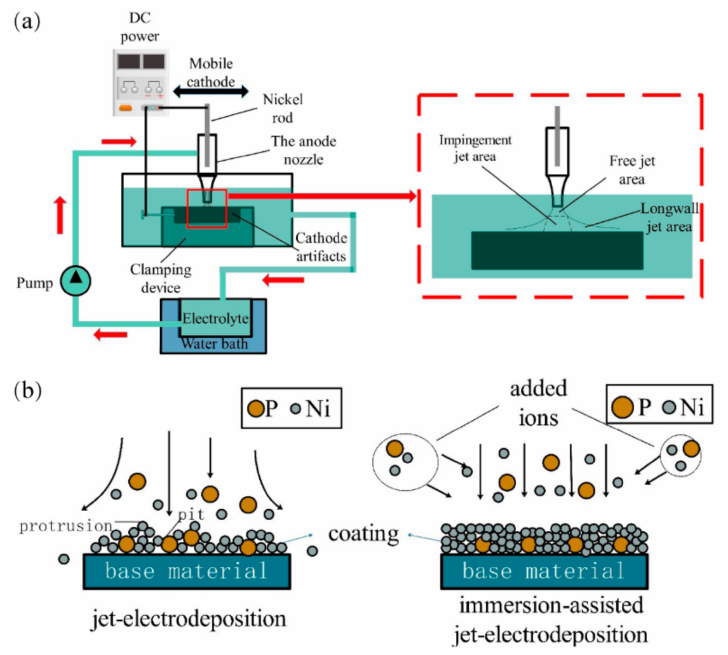
Figure 1. Schematic diagram of electrodeposition process. ( a ) Experimental device; ( b ) electrodeposi- tion